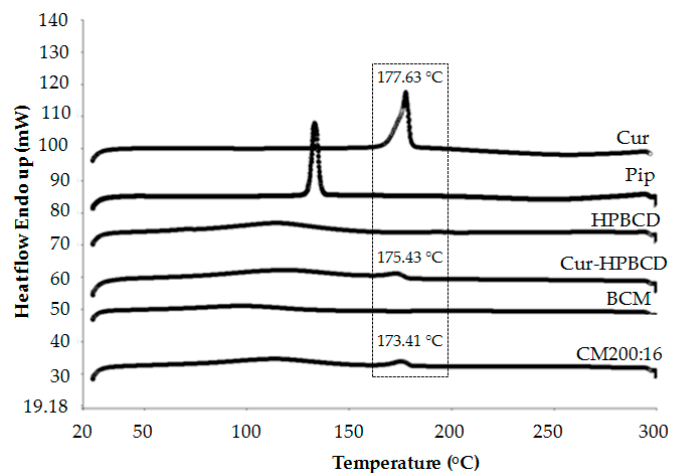
Figure 4. Differential scanning calorimetry (DSC) thermograms of the composite membrane (CM200:16) in comparison with curcumin (Cur), piperine (Pip), hydroxypropyl- β -cyclodextrin (HPBCD), curcumin-hydroxypropyl- β -cyclodextrin inclusion complex (Cur-HPBCD), and a blank composite membrane (BCM).